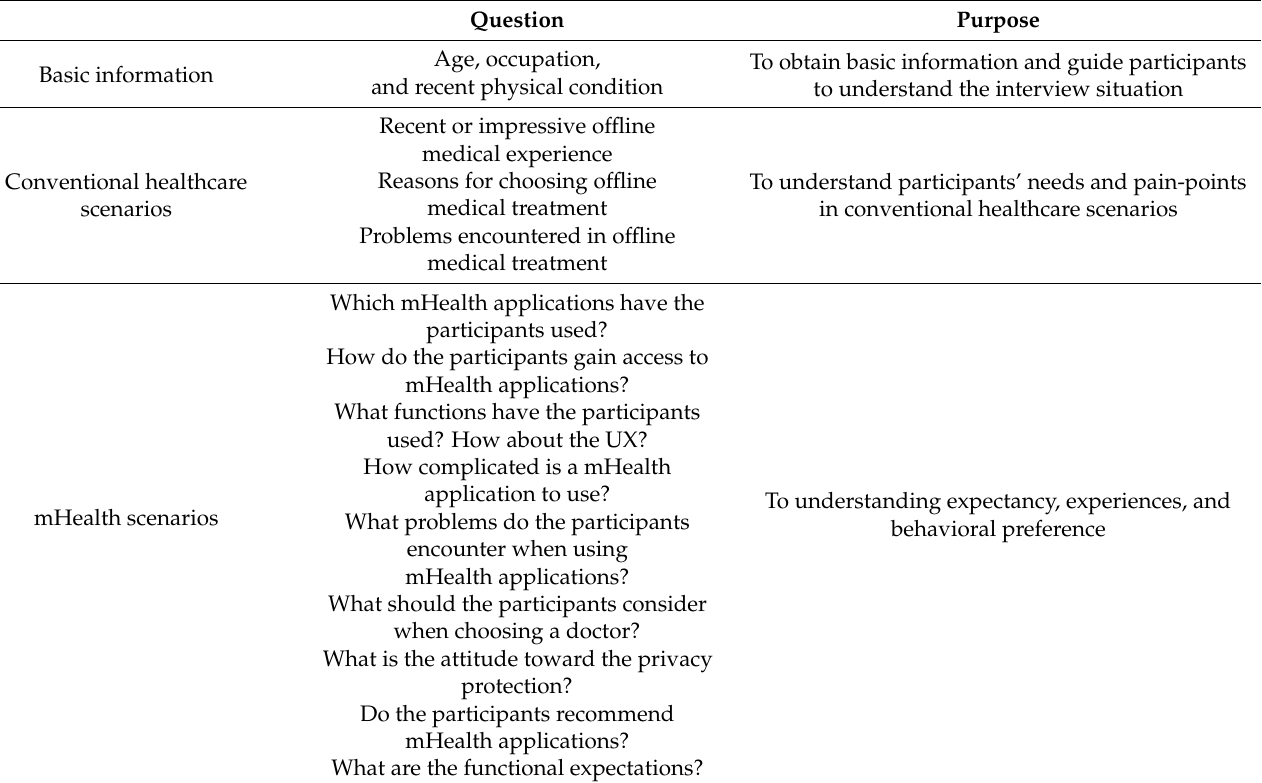
Table 1. The interview question